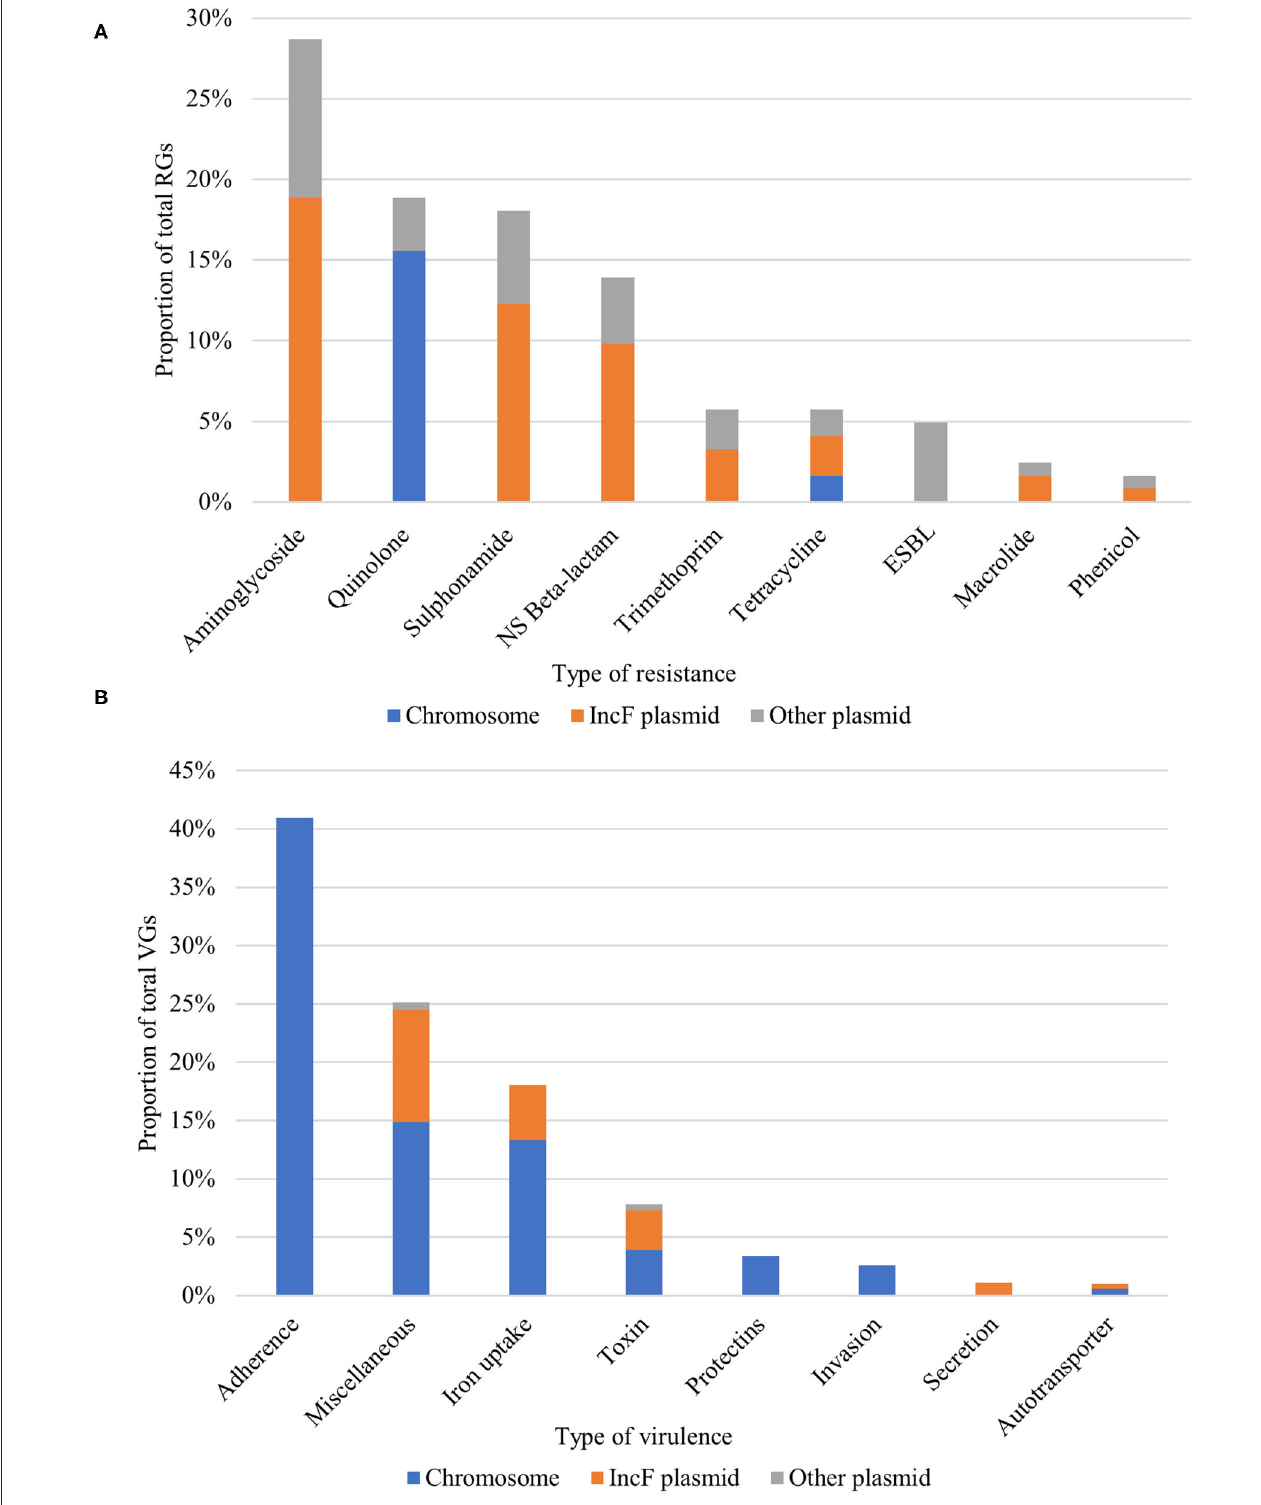
FIGURE 3 | Proportion and genomic localization of (A) resistance genes (RGs) and (B) virulence genes (VGs). NS Beta-lactam, Narrow-spectrum beta-lactam; ESBL, Extended-spectrum beta-lactam.